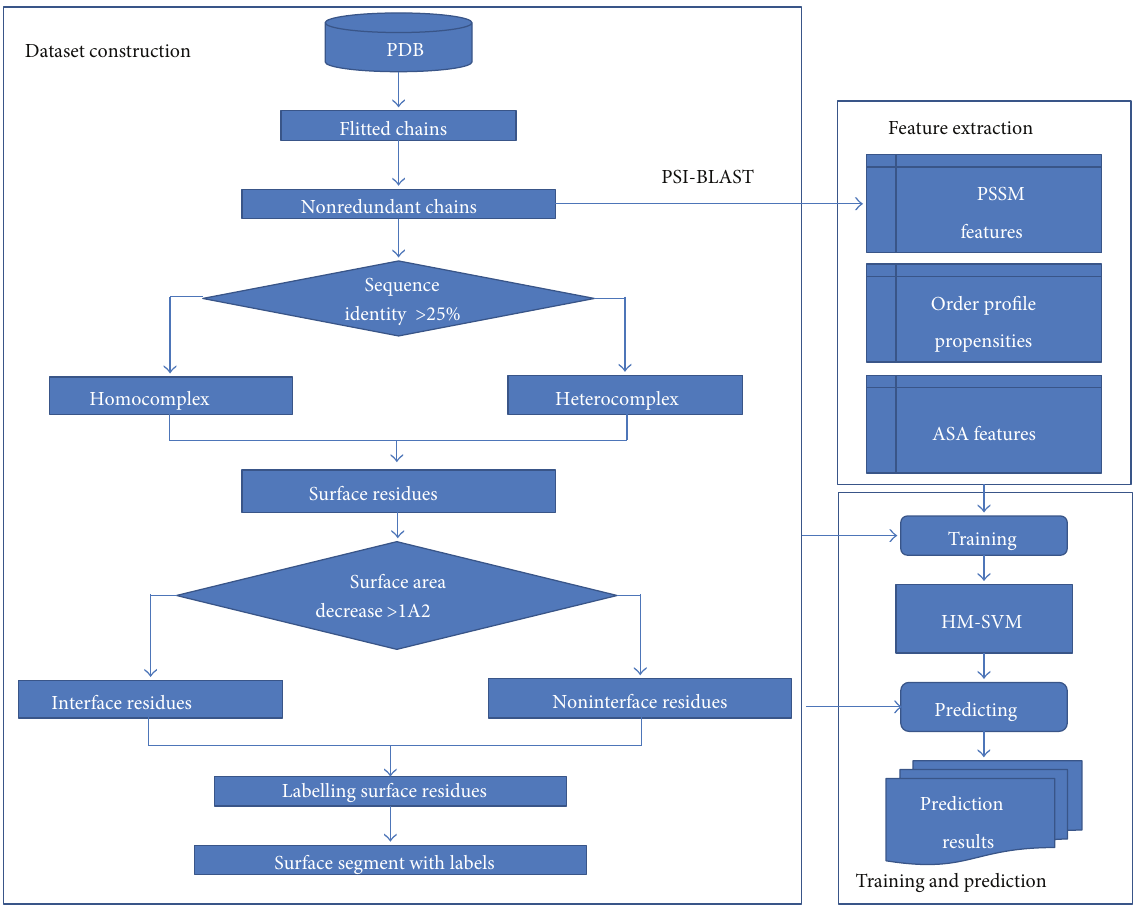
Figure 1: Overview of the proposed framework for protein binding site